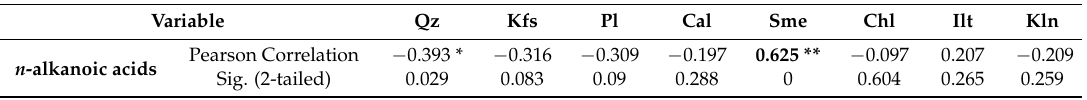
Table 9. Correlation matrix of the total content in n -alkanoic acids ( µ g/g) and mineral content of the